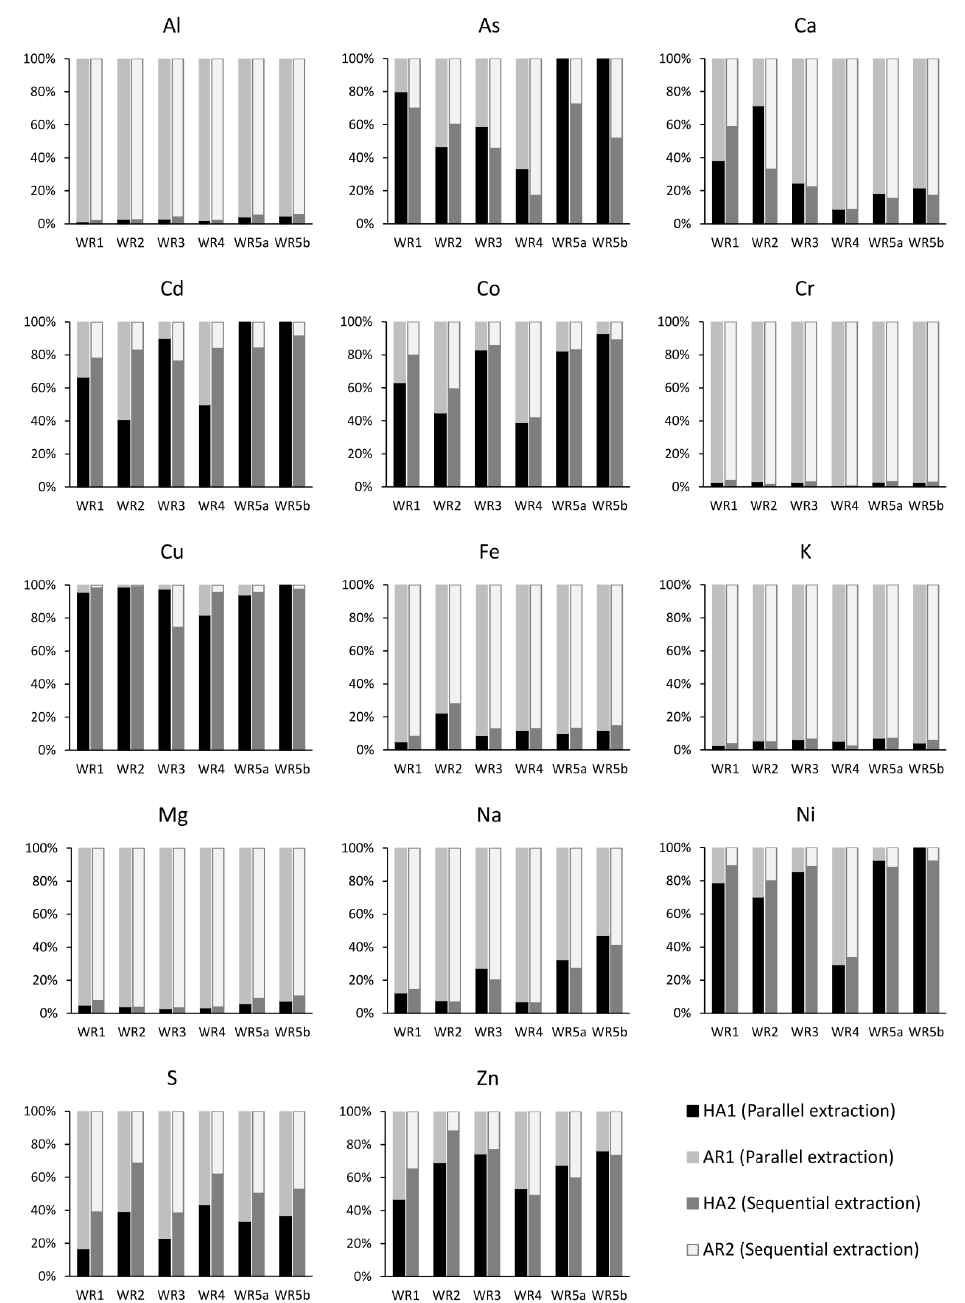
Figure 3. The HA1 and HA2 extraction results compared with the corresponding AR1 and AR2 extraction results of the samples WR1-5b. The AR extractable values as 100% (HA2 + AR2 for the sequential extraction).